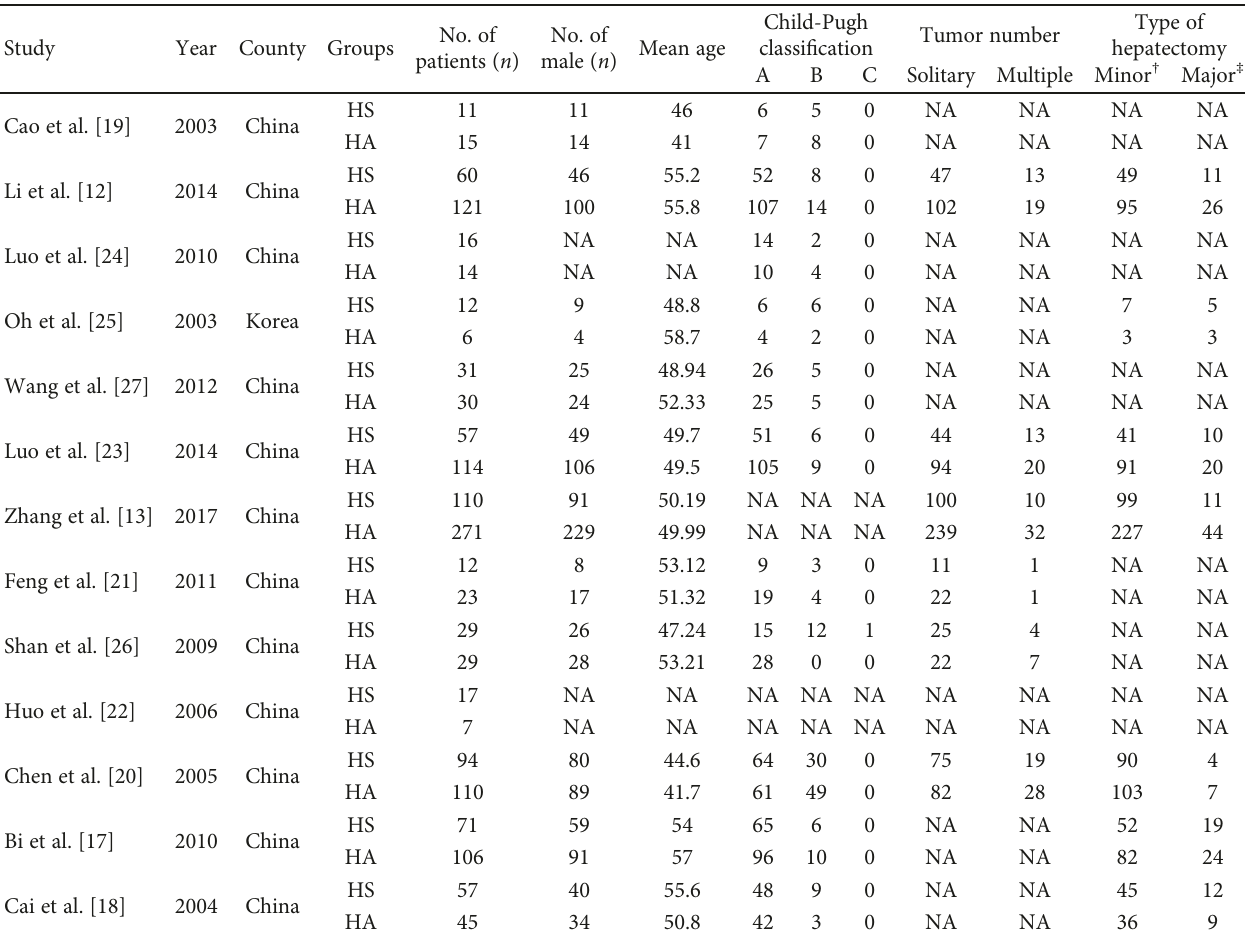
Table 1: Basic characteristics of all studies pooled in the